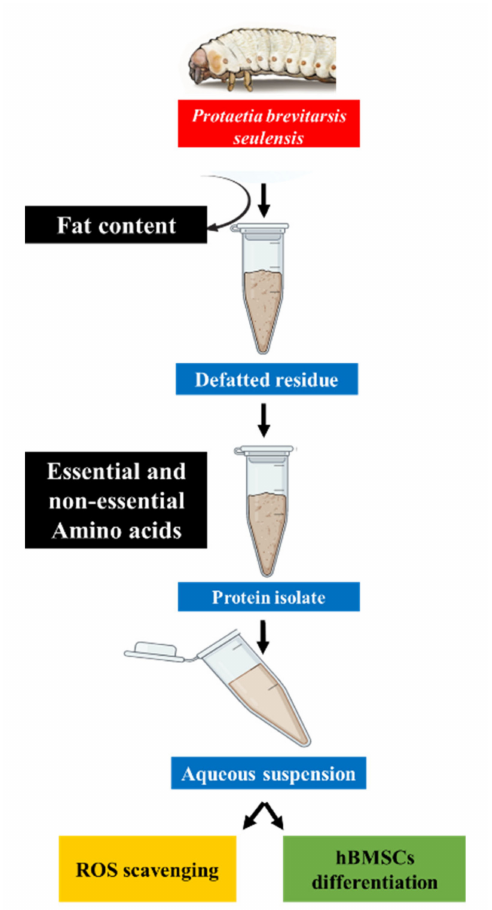
Figure 1. Schematic illustration of protein extraction from Protaetia brevitarsis seulensis